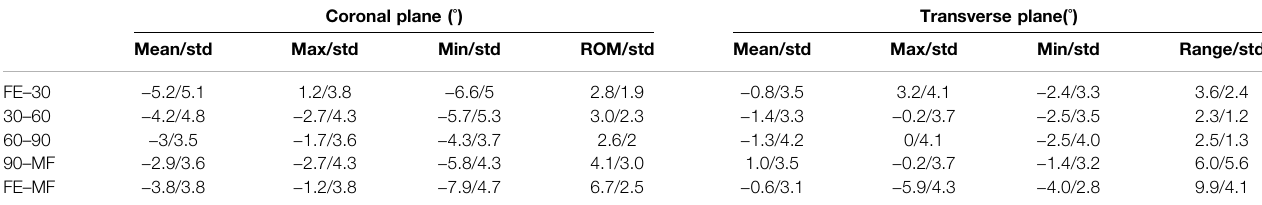
TABLE2| Valuesrepresentingtheanglebetweentheaveragerotationaxisandmedial – lateralepicondyleaxisinthecoronalplaneandtransverseplaneatdifferentphasesof fl exion. Positive values indicate the average rotation axis was varus and internally rotated to the medial – lateral epicondyle axis (MLA) (FE – 30, full extension to 30 ° fl exion;